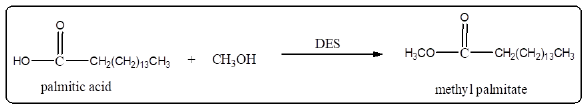
Figure 23: DES catalyzed esterification of palmitic acid with methanol.